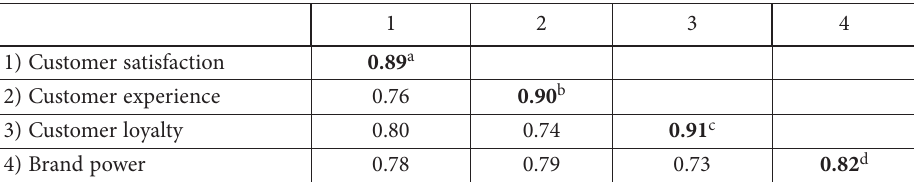
Table 3. Discriminant validity